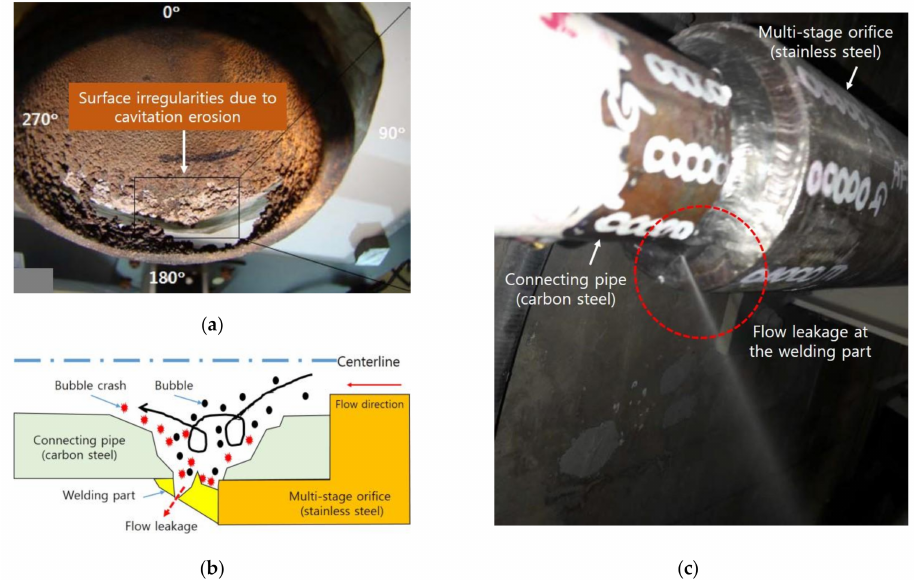
Figure 2. Cavitation erosion as the main cause of the flow leakage at the welding part: ( a ) cross- section of the leakage part [1]; Reproduced from [1], Korea Hydro & Nuclear Power: 2018. ( b ) schematic diagram for the cavitation erosion mechanism [1]; Reproduced from [1], Korea Hydro & Nuclear Power: 2018 and ( c ) flow leakage at the welding part [2]. Reproduced from [2], Korea Society for Fluid Machinery: